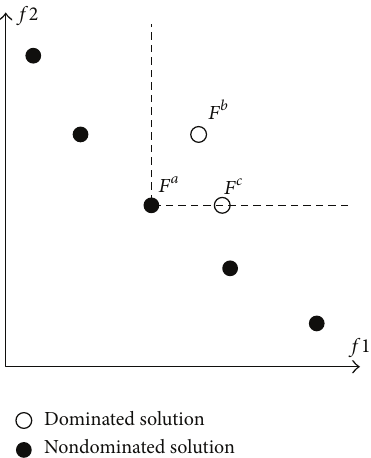
Figure 1: Dominance relation for two-objective